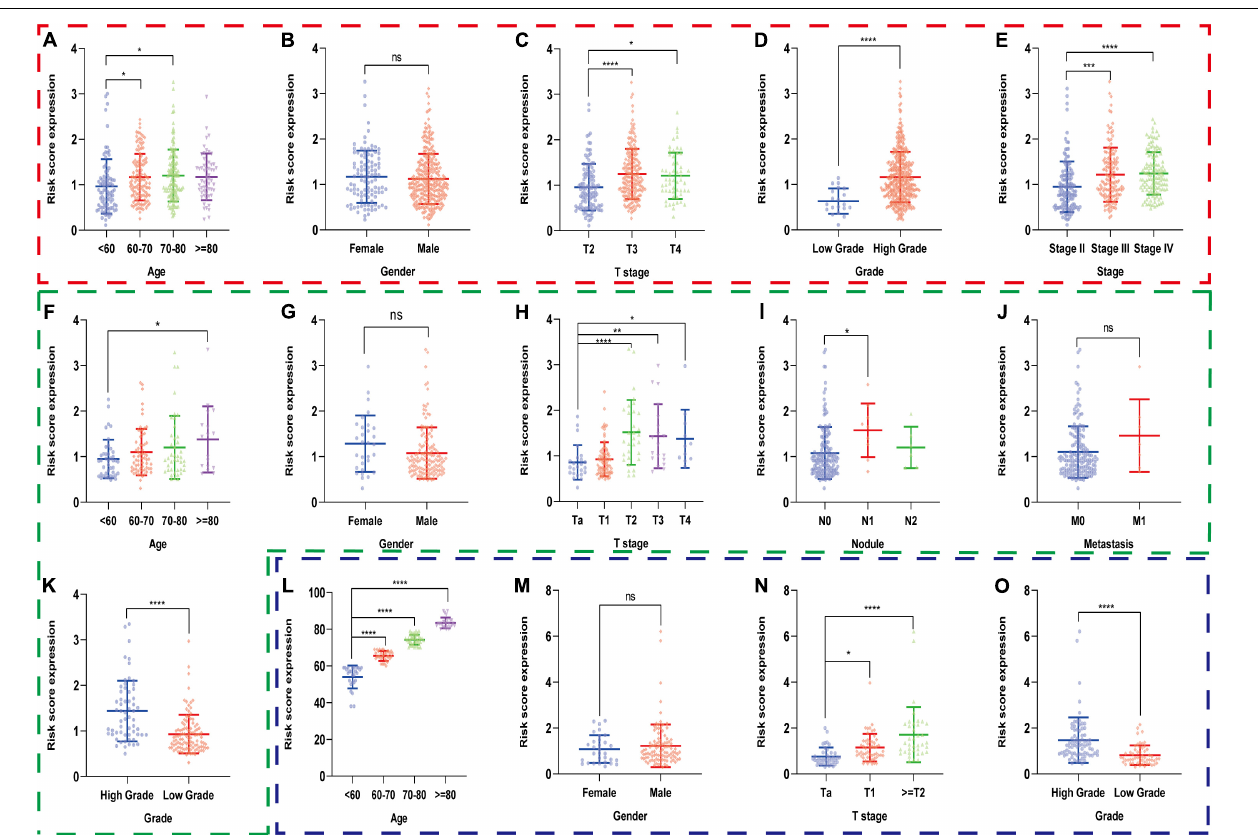
FIGURE 7 | The risk scores of patients in different subgroups stratified by clinicopathologiocal parameters in the training set and two validation sets. The red, green, and blue dashed boxes corresponded to the TCGA database, GSE13507, and GSE32548, respectively. The risk scores were compared in the subgroups of (A) age, (B) gender, (C) T stage, (D) AJCC stage, and (E) pathological grade in the TCGA dataset, and were validated in the subgroups of (F) age, (G) gender, (H) T stage, (I) nodule, (J) metastasis, and (K) grade in GSE13507 and in the subgroups of (L) age, (M) gender (N) T stage, and (O) grade in GSE32548, respectively. * P < 0.05; ** P < 0.01; *** P < 0.001; **** P < 0.0001; ns, not